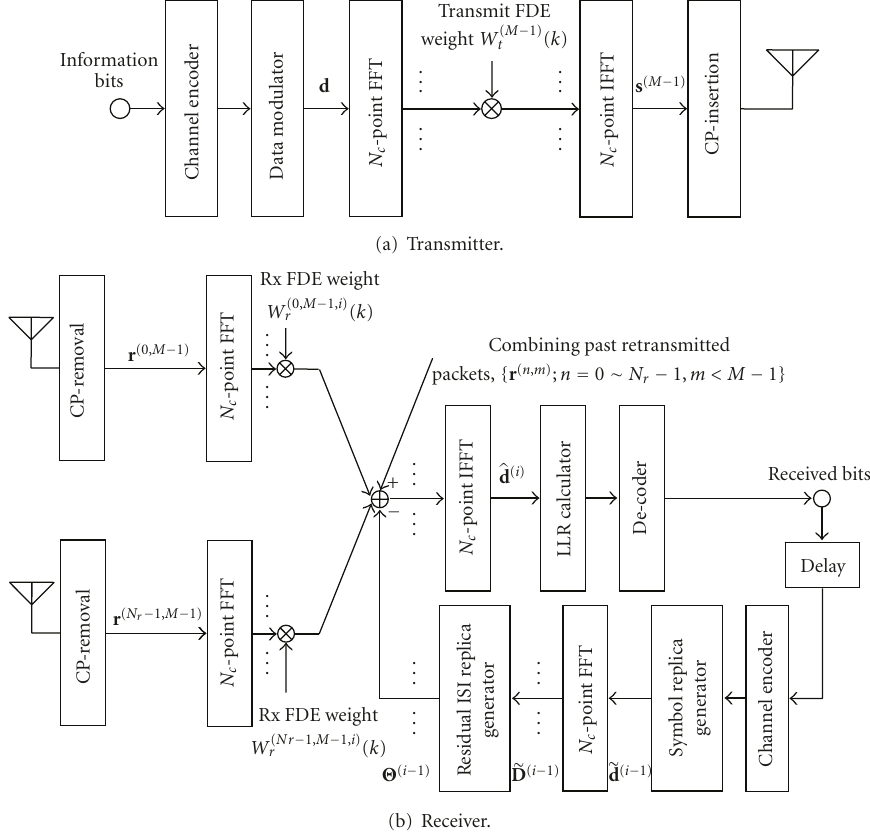
Figure 2: Transmitter/receiver